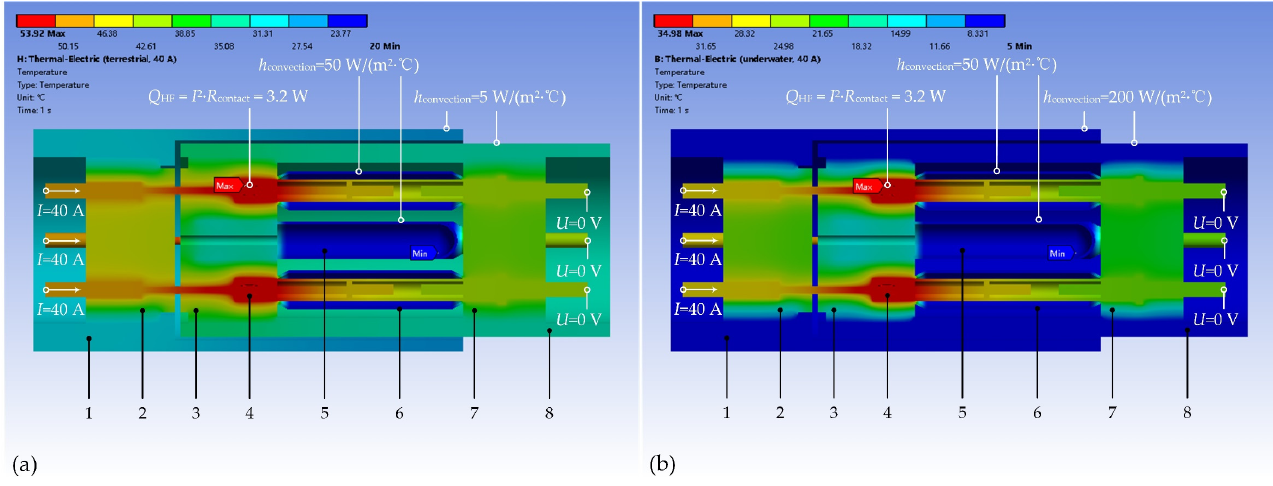
Figure 8. The temperature distribution of the proposed wet-mateable electrical connector in ( a ) terrestrial environment (the ambient temperature is 20 °C) and ( b ) underwater environment (the ambient temperature is 5 °C): 1-plug shell; 2-plug pedestal; 3-receptacle front pedestal; 4-electric contact; 5-primary resilient bladder; 6-secondary resilient bladder; 7-receptacle rear pedestal; 8-receptacle shell.